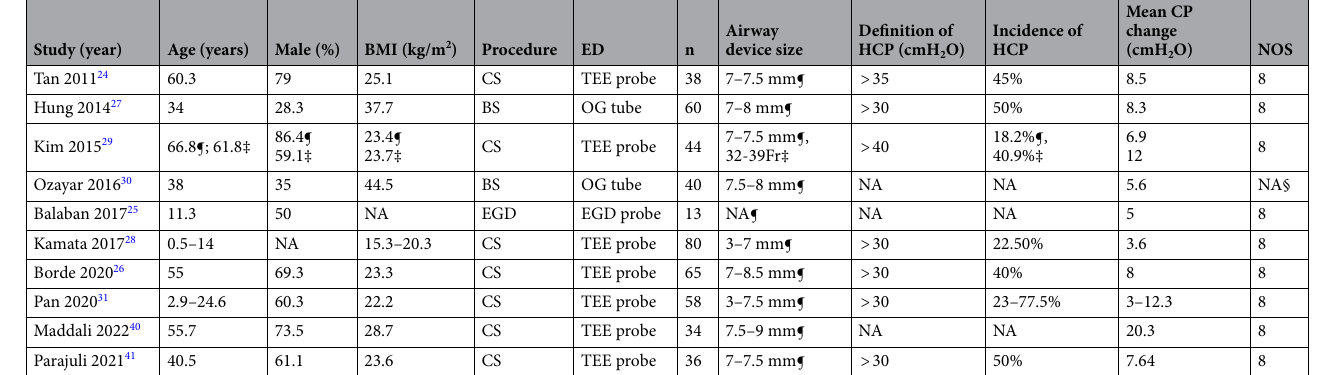
Table 1. Characteristics of included studies (n = 10). BMI body mass index; EGD esophagogastroduodenoscopy; OG orogastric tube; TEE transesophageal echocardiography; HCP high cuff pressure; CP cuff pressure; BS Bariatric surgery; CS Cardiac surgery; NA not available; ED Esophageal device; ¶single tracheal tube; ‡ DLT double lumen tube; NOS Newcastle − Ottawa scale; §risk of bias assessed using the Cochrane Collaboration risk of bias